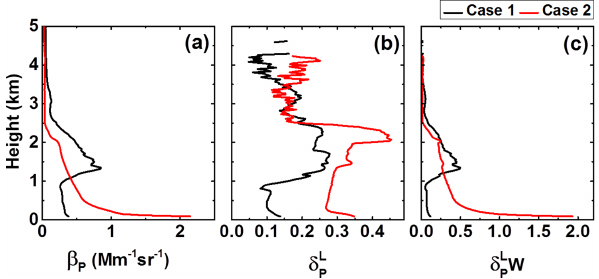
Figure 12. Separation of data of group 6 at Osaka on the ba- sis of case 1 (black) and case 2 (red). Shown are (a) backscat- ter coefficients, (b) linear particle depolarization ratios ( δ L (c) weighted linear particle depolarization ratios ( δ LW